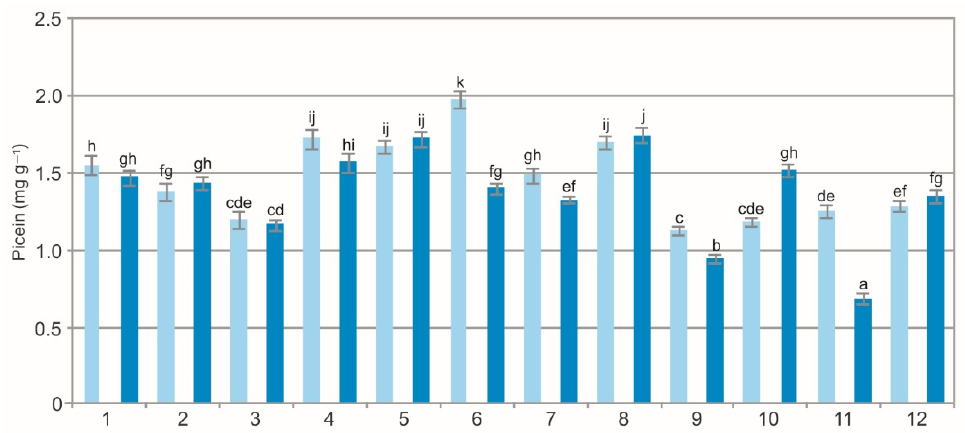
Figure 7. Picein concentration in water (light blue) and ethanol (dark blue) leaf extracts from bearberry plants in different populations. The values designated by the different letters are significantly different ( p < 0.05).